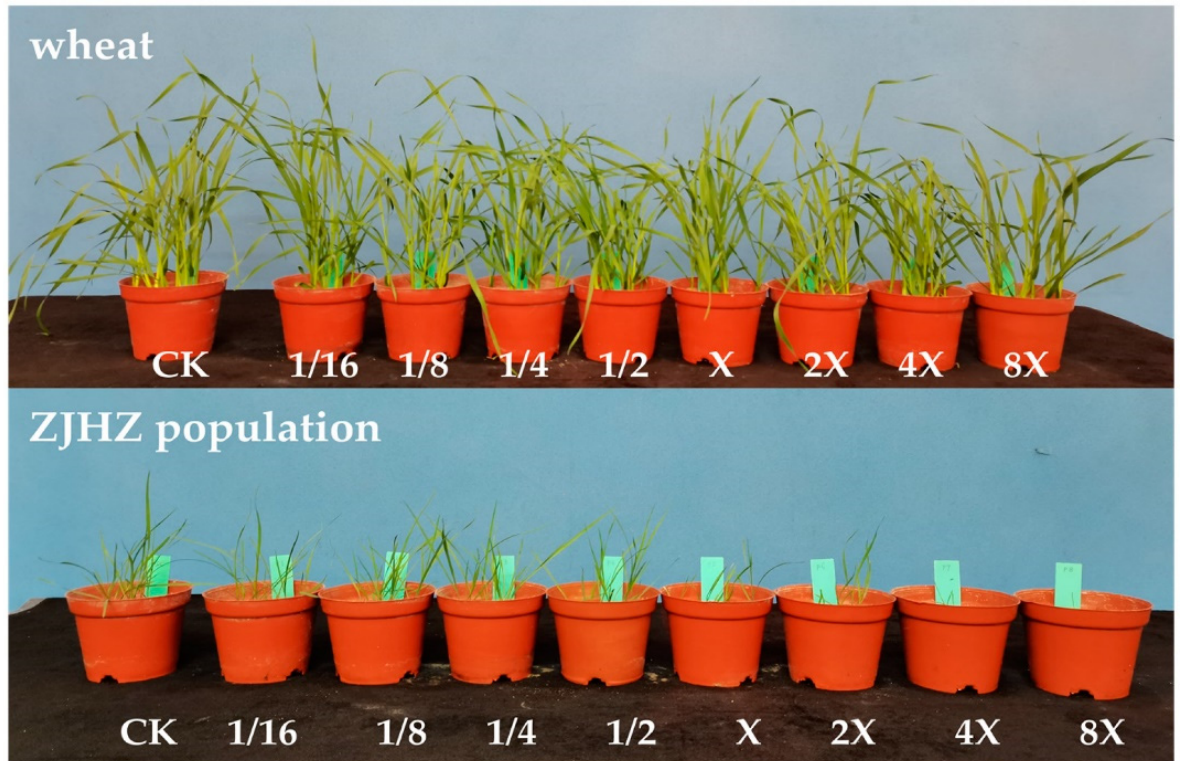
Figure 1. Photographs of wheat ( upper ) and R. kamoji ZJHZ ( lower ) 21 days after being treated with different doses of butachlor. The first row shows the untreated control (CK), followed by different doses of butachlor (X represents the recommended field dose 1350 g a.i. ha − 1 ).